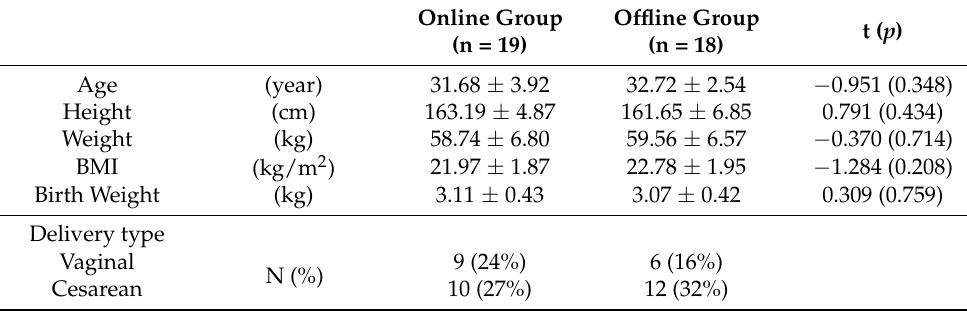
Table 1. Participant characteristics (N =